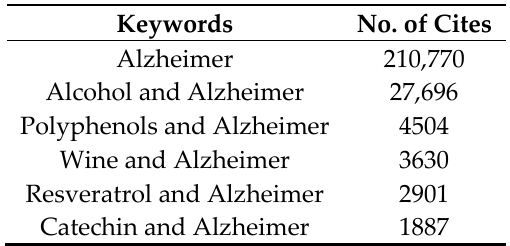
Table 2. Number of articles found in the bibliographic search of Alzheimer’s disease using